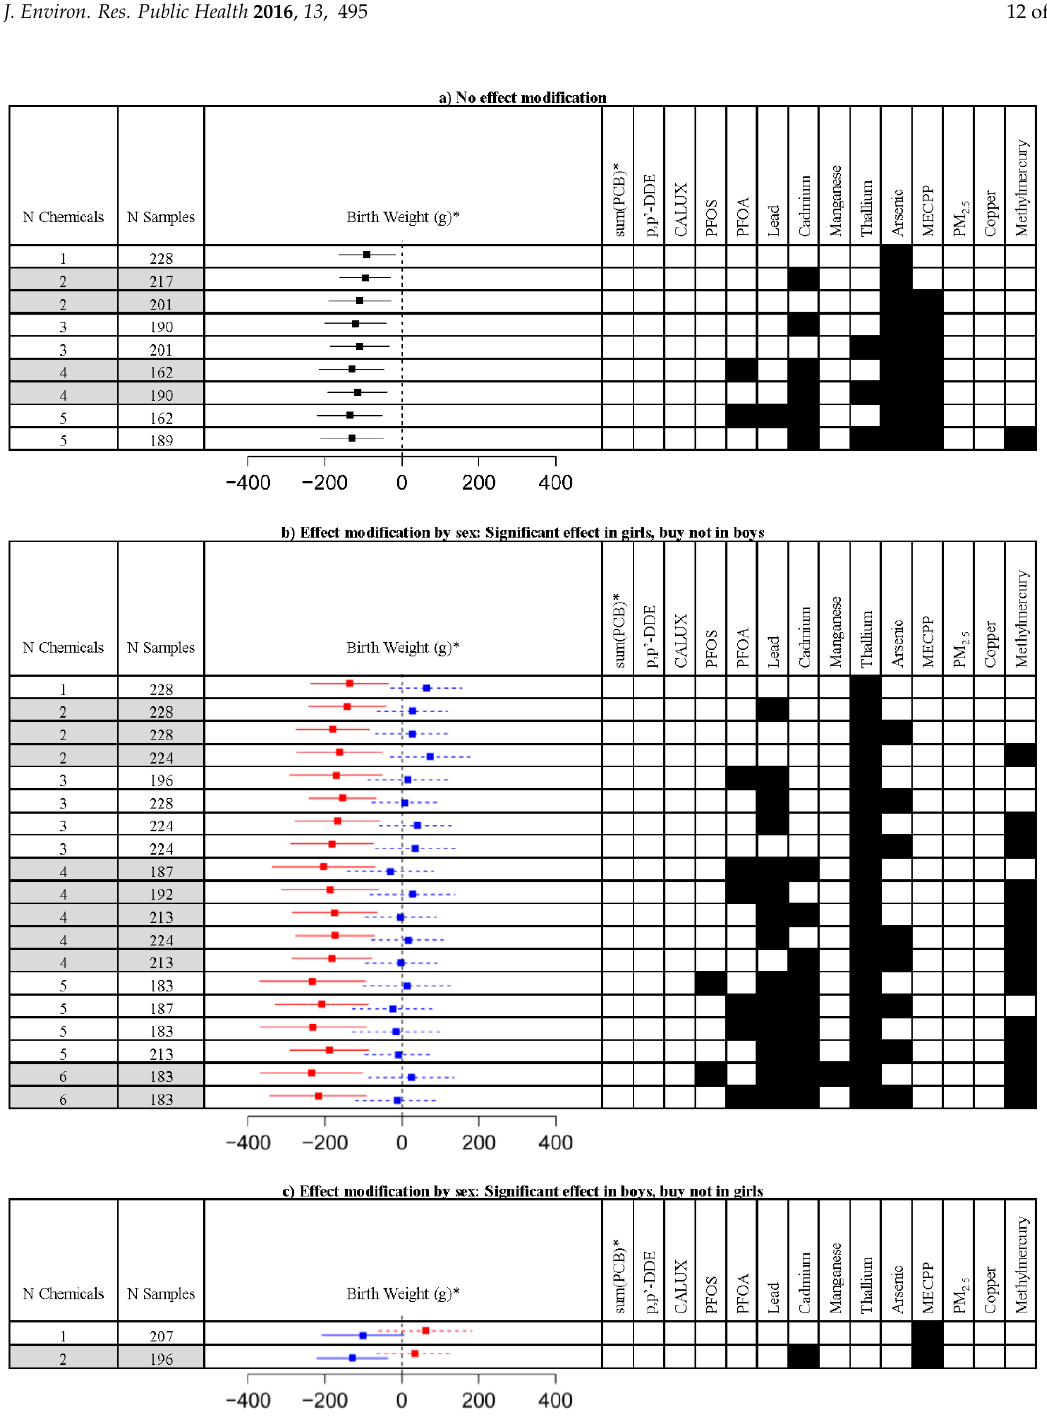
Figure 4. Results of mixture regression algorithm showing an increase in the association between birth weight and exposure by growing complexity of mixtures. The black rectangles indicate the exposure biomarkers that are included in the model. The estimate of the association between exposure and birth weight is given for an increase of the mixture Z-score with the interquartile range. The estimated effects and corresponding confidence limits (95%) are shown by squares and lines, respectively. Significance (at the 5% level) is demonstrated when the confidence interval does not include 0. ( a ) The models adjusted for gestational age, child’s sex, smoking of the mother during pregnancy, parity and maternal prepregnancy BMI; ( b , c ) Models that include modification of the effect by child’s sex that focus on significant effects in girls and boys, respectively. The effect in girls is shown in red, while the effect in boys is shown in blue. Numerical data (estimates, 95% confidence limits, p -value, R 2 , and MSE) are included in Tables S3–S5. * Three marker PCBs ( i.e. , PCB-180, PCB-153, and PCB-138) were summed prior to analysis.